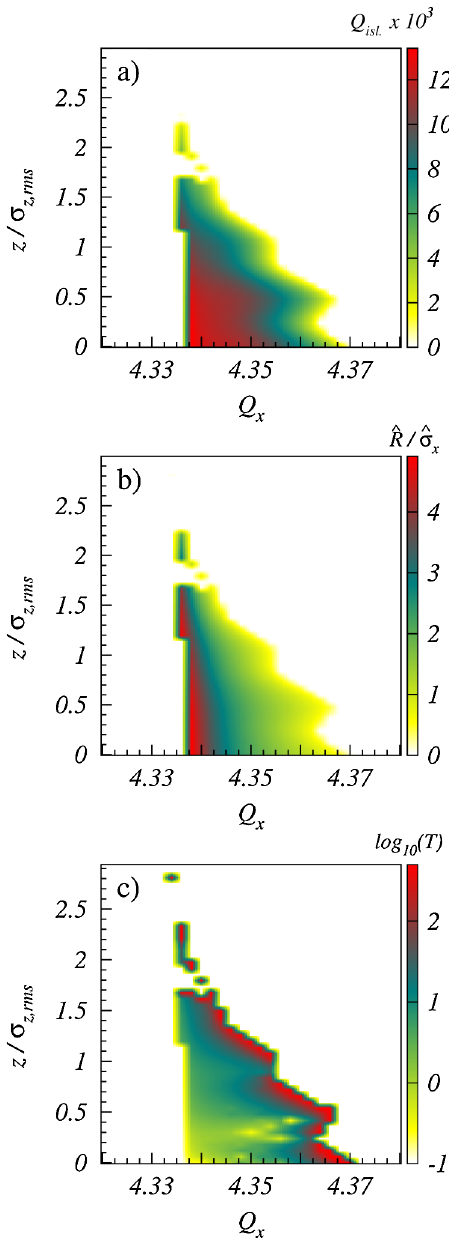
FIG. 20. Main feature characterizing the periodic resonance crossing: (a) Island tune vs z , and Q x . (b) Fixed point radius (in CS) vs z , and Q x . (c) Adiabaticity parameter T vs z , and Q x . In the white areas the fixed points do not